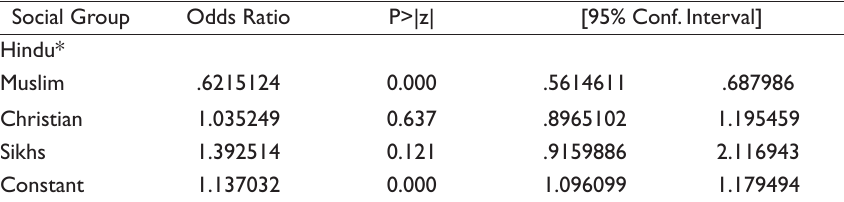
Table 5. Logistic Regression Model for Religious Groups in India Social Group